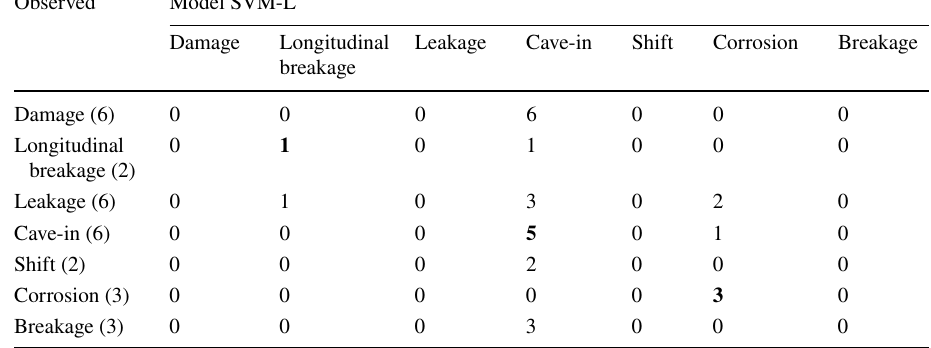
sewers’ damages—model SVM- L, testing set